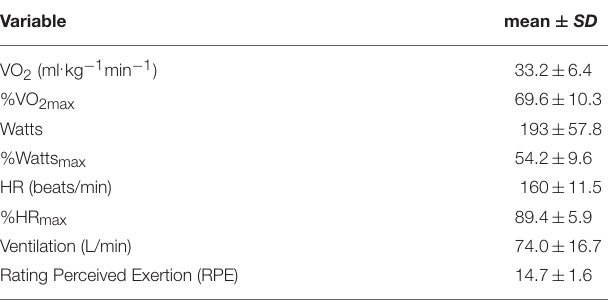
TABLE 2 | Performance variables averaged for entire 75 km cycling time trial ( N = 20 male cyclists).